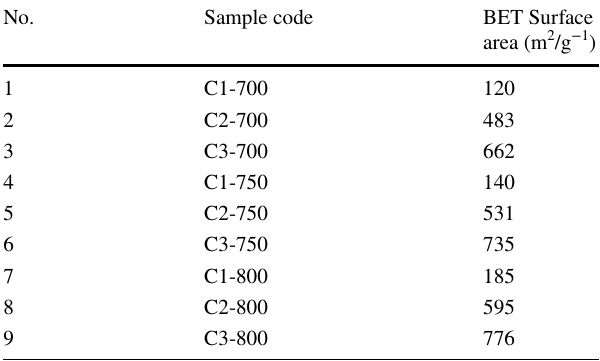
Table 3 BET surface area of prepared activated carbon